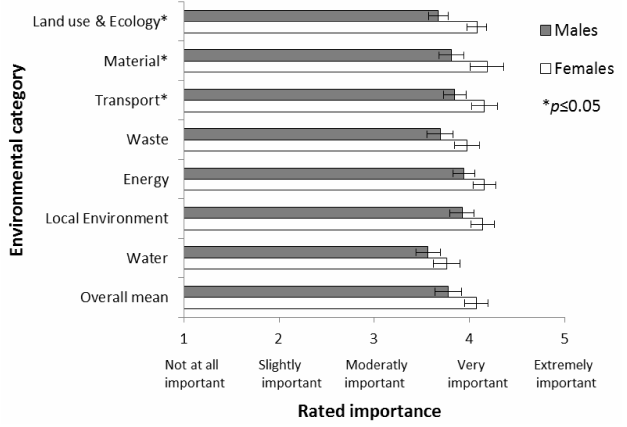
Figure 2. Mean values for estimated importance across a range of environmental categories. Error bars represent the standard error of means.